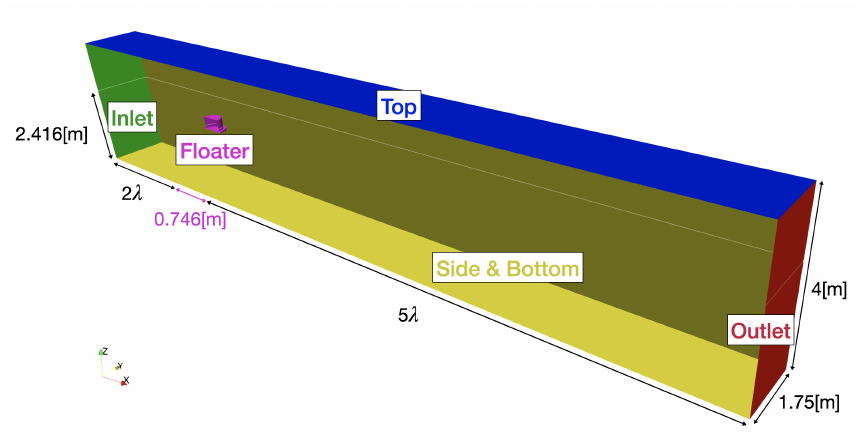
Figure 5. Schematic view of the computational domain. The numerical domain was divided into cells by the following